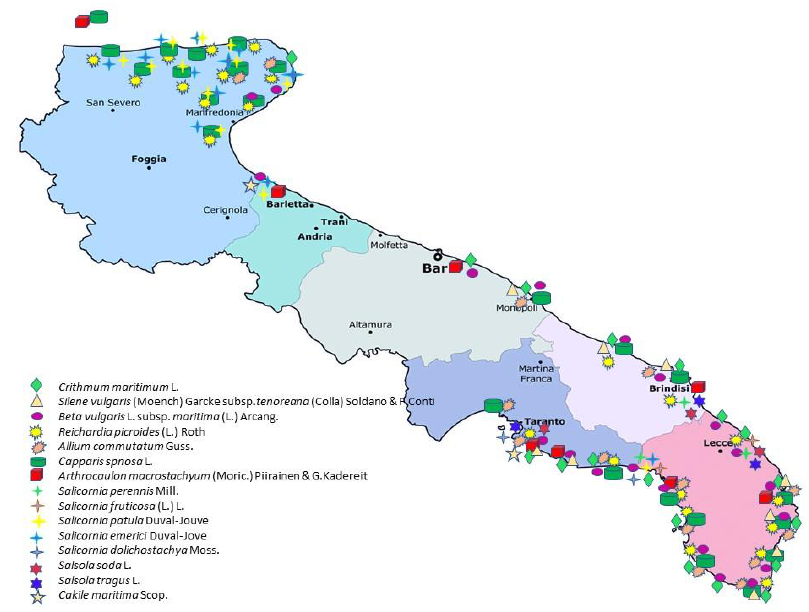
Figure 4. Distribution, across the Apulia region, of the food use of halophytes and halotolerant species treated in this contribution, according to our field observations and literature data.